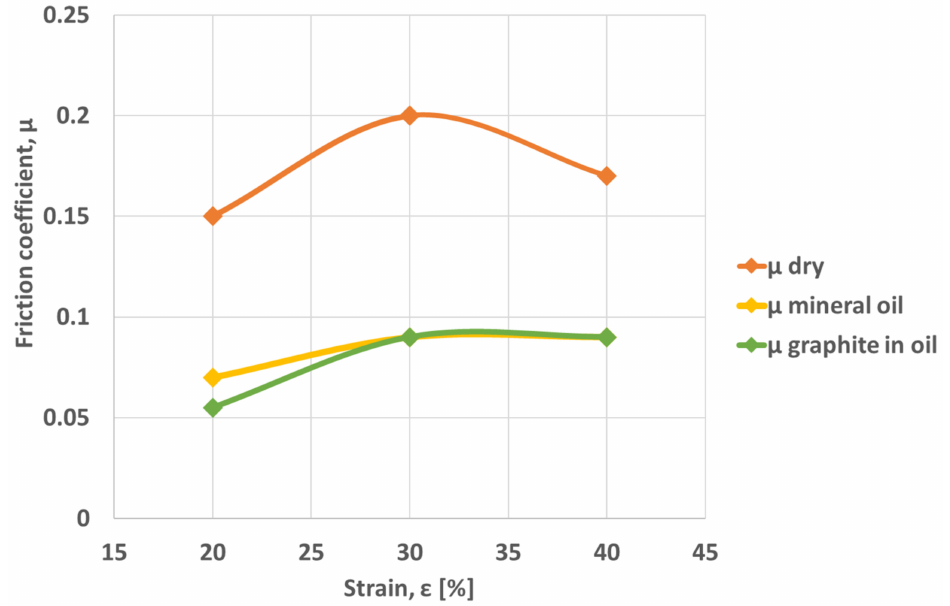
Figure 8. The variation of the friction coefficient vs. friction conditions and strains.